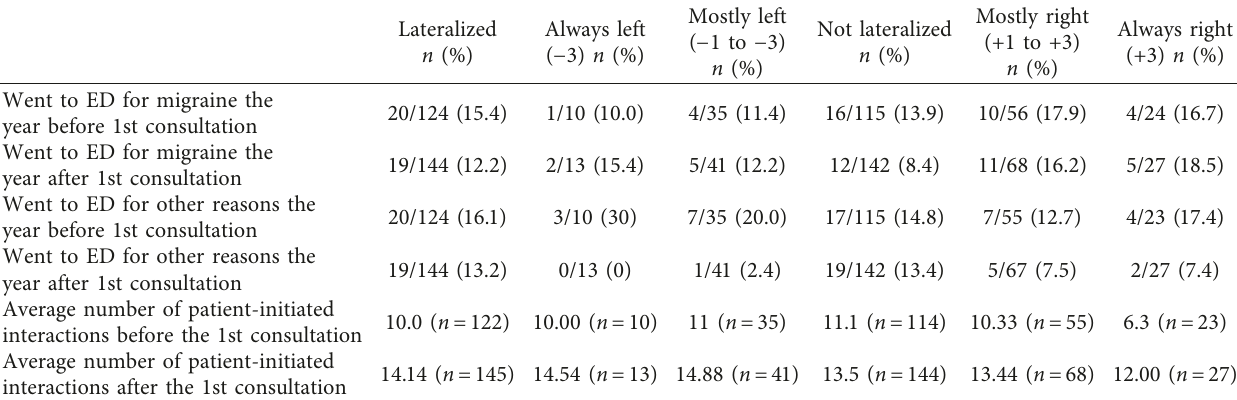
Table 8: Healthcare utilization behavior in patients with lateralized